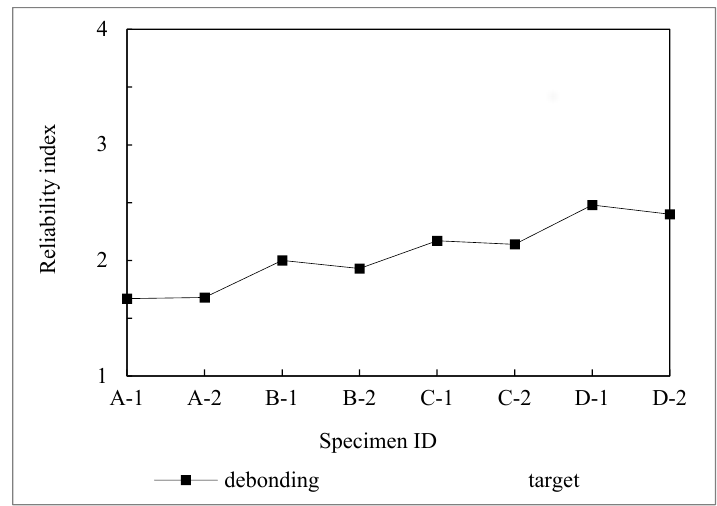
Figure 6. Reliability indices of debonding limit state.